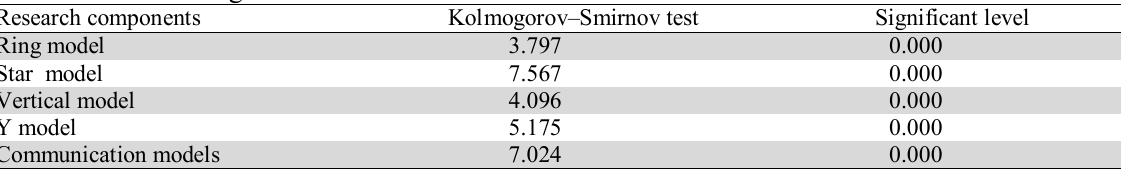
The results of Kolmogorov–Smirnov test